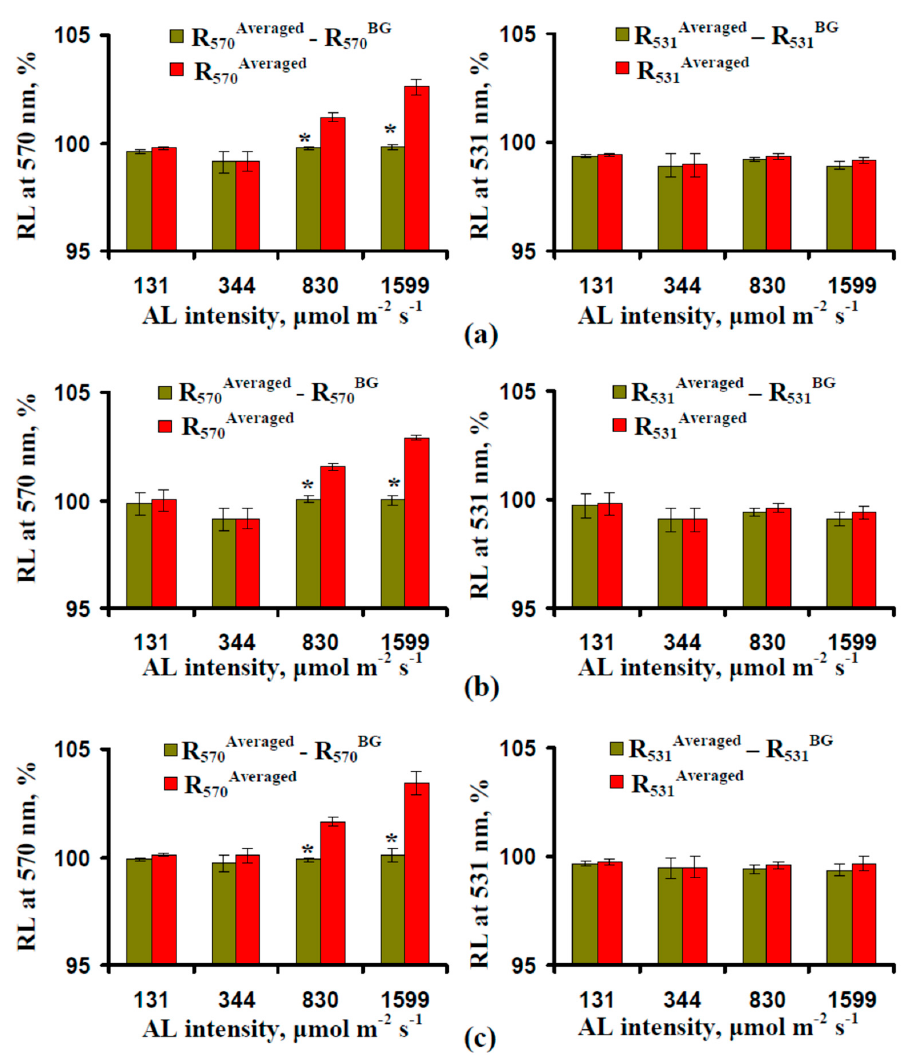
Figure 2. Changes in the RL intensity at 531 and 570 nm under illumination by AL with different intensities in pea ( a ), wheat ( b ), and pumpkin ( c ) ( n = 6). The absolute intensity of RL ( R 531(570) Averaged ) and the magnitude of the change in the RL intensity during the GYL pulse ( R 531(570) Averaged − R 531(570) BG ) were used. R 531(570) BG is the absolute intensity of the reflected light at 531 (570) nm before the GYL pulse and R 531(570) Averaged is the averaging of the absolute intensities of the reflected light at 531 (570) nm during the GYL pulse. The intensities of RL before illumination by AL were assumed to be 100%. The GYL pulse was started after 20 s of illumination by AL (maximum intensity at 630 nm, 1599 μ mol m − 2 s − 1 ). * indicates that the difference between R 531(570) Averaged and R 531(570) Averaged – R 531(570) BG was significant (p < 0.05).